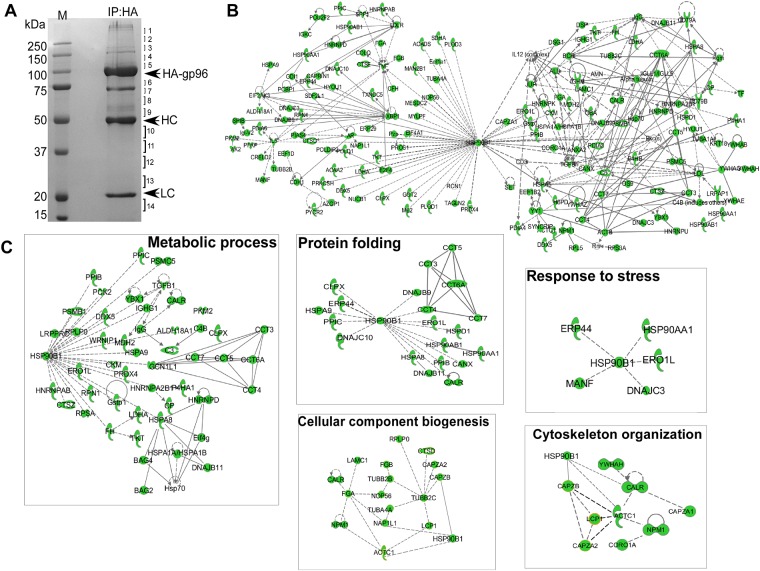
Mapping the gp96 interaction network.A) PreB cells infected with HA-gp96 retrovirus were selected with 5 μg/ml blasticidin for 5 days. HA-gp96 from the total cell lysates was immunoprecipitated with HA antibody. The eluate was resolved on SDS—PAGE and stained with Coomassie blue. The gel was cut into 14 pieces as indicated, trypsin-digested and sequenced by mass spectrometry. HC and LC represent Ig heavy chain and light chain, respectively. B) 130 putative gp96 interactors identified in PreB IP dataset were mapped into a network based on the literature available in the IPA database. Each direct or indirect interaction is supported by at least one piece of evidence from the scientific literature. Solid line showing direct interaction; dotted lines showing indirect or no interaction. C) Subnetwork of GO processes contained within the gp96 interaction network: metabolic process, protein folding, response to stress, cytoskeleton organization and cellular component biogenesis.